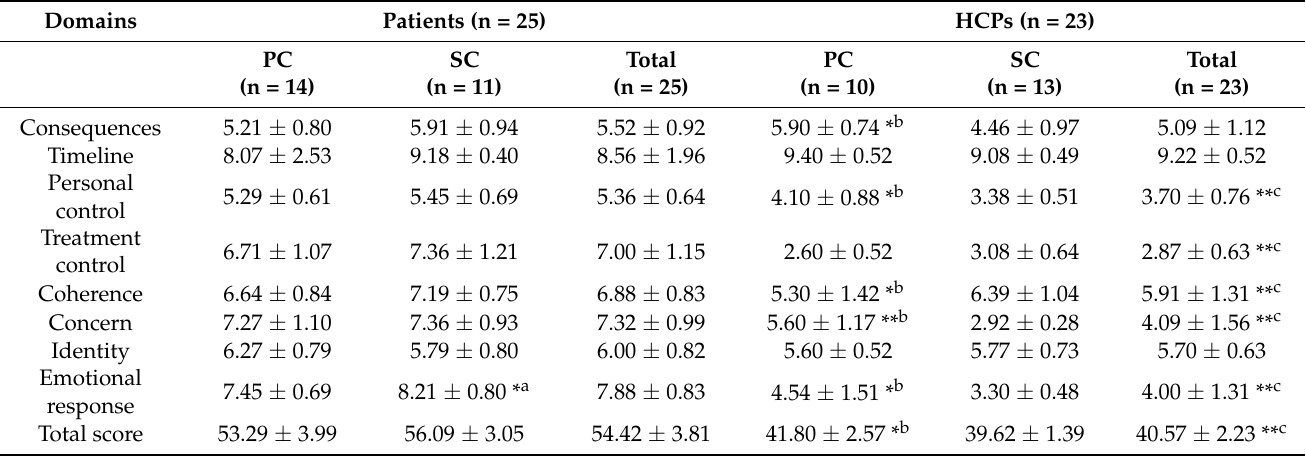
Table 4. Comparison of Brief Illness Perception Questionnaire scores between patients and healthcare professionals (mean ±